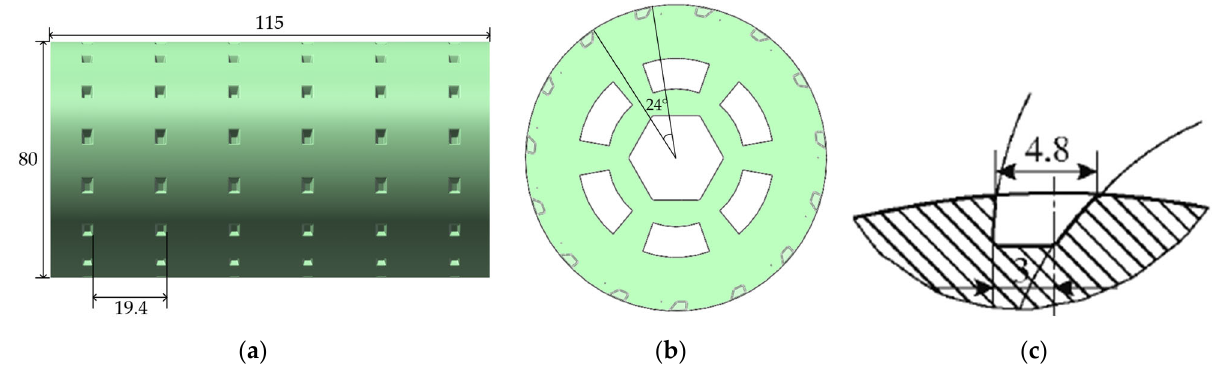
Figure 3. ( a ) Size of seed ‐ metering wheel and axial distribution of model ‐ hole (mm), ( b ) circumferential distribution of model ‐ hole, and ( c ) model ‐ hole sectional drawing (mm). The width and depth of the model ‐ hole are 3.5 mm and 2.6 mm.